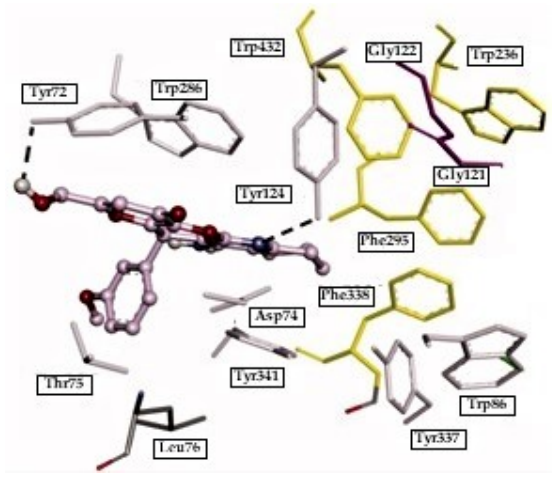
Figure 5. Molecular modeling of ( R )- 6d in the second distinct site (PAS) of h AChE (adapted from [69]). Important interactions include π-π stacking with Trp286 and Tyr341 and H-bonds of the primary hydroxyl group with Tyr72 and the tacrine-like amino group with Tyr124. 4. Pyranonaphthalene, Pyranoquinoline, and Pyranonaphthoquinone Tacrines